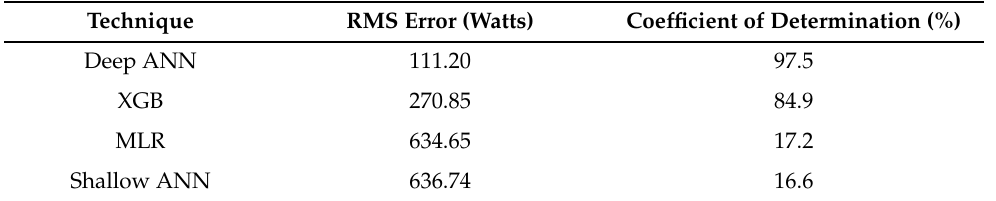
Table 11. The result of the